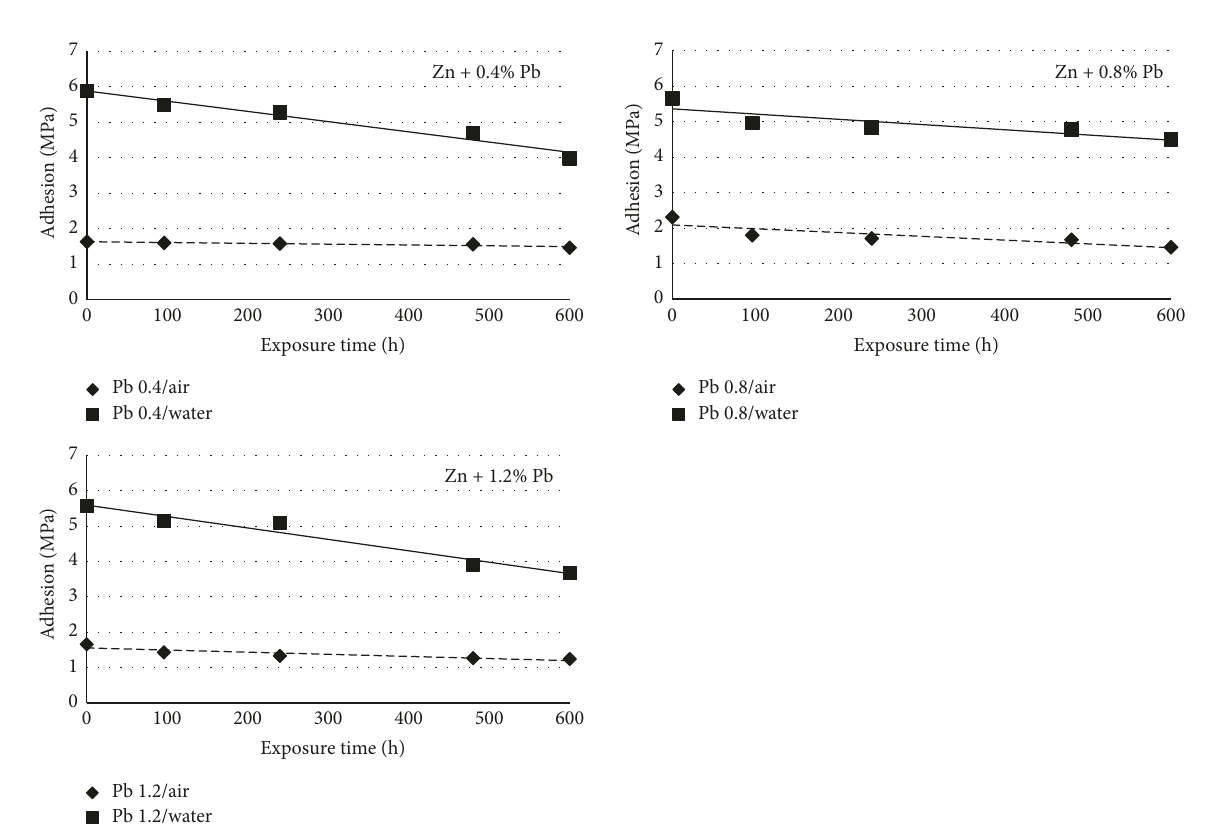
Figure 11: The tendency of adhesion changes depending on the cooling